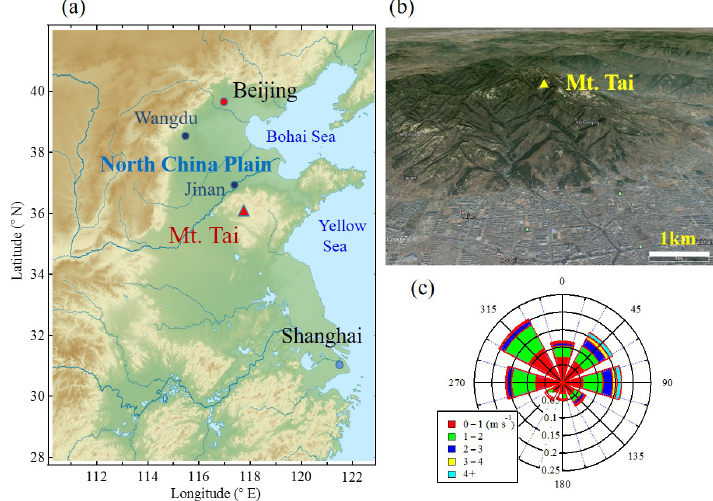
Figure 1. (a) Map of northern China showing the location of the mountaintop measurement site (Mt. Tai) in the North China Plain, (b) ex- panded topographic view of Mt. Tai and surrounding areas, and (c) a wind rose for the study period of summer